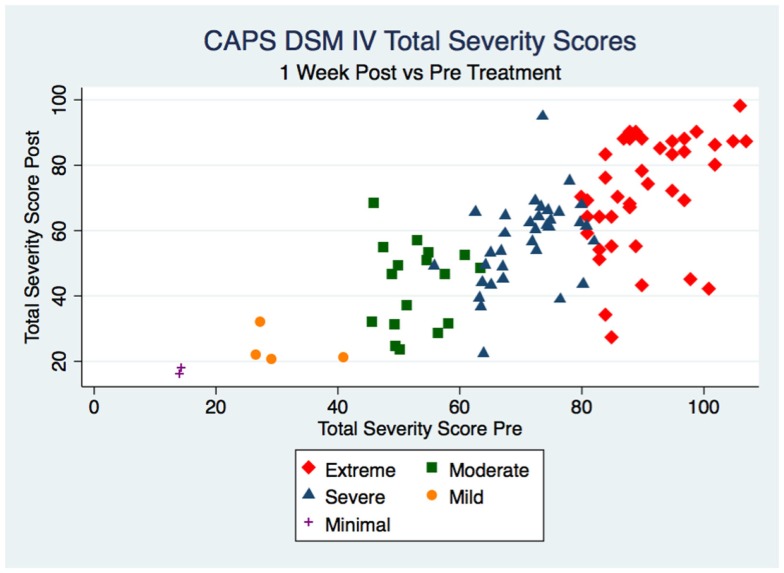
Scatter plot of 1 week post- vs. pre-treatment scores color coded for the different categories.